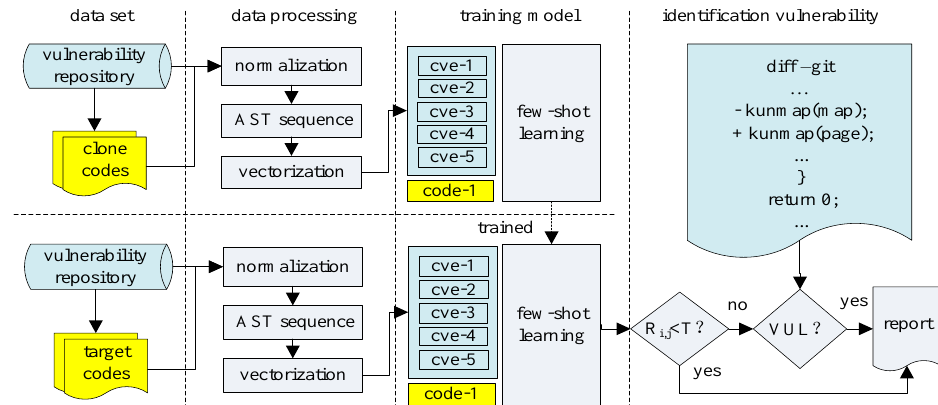
Figure 2 . Overall framework of